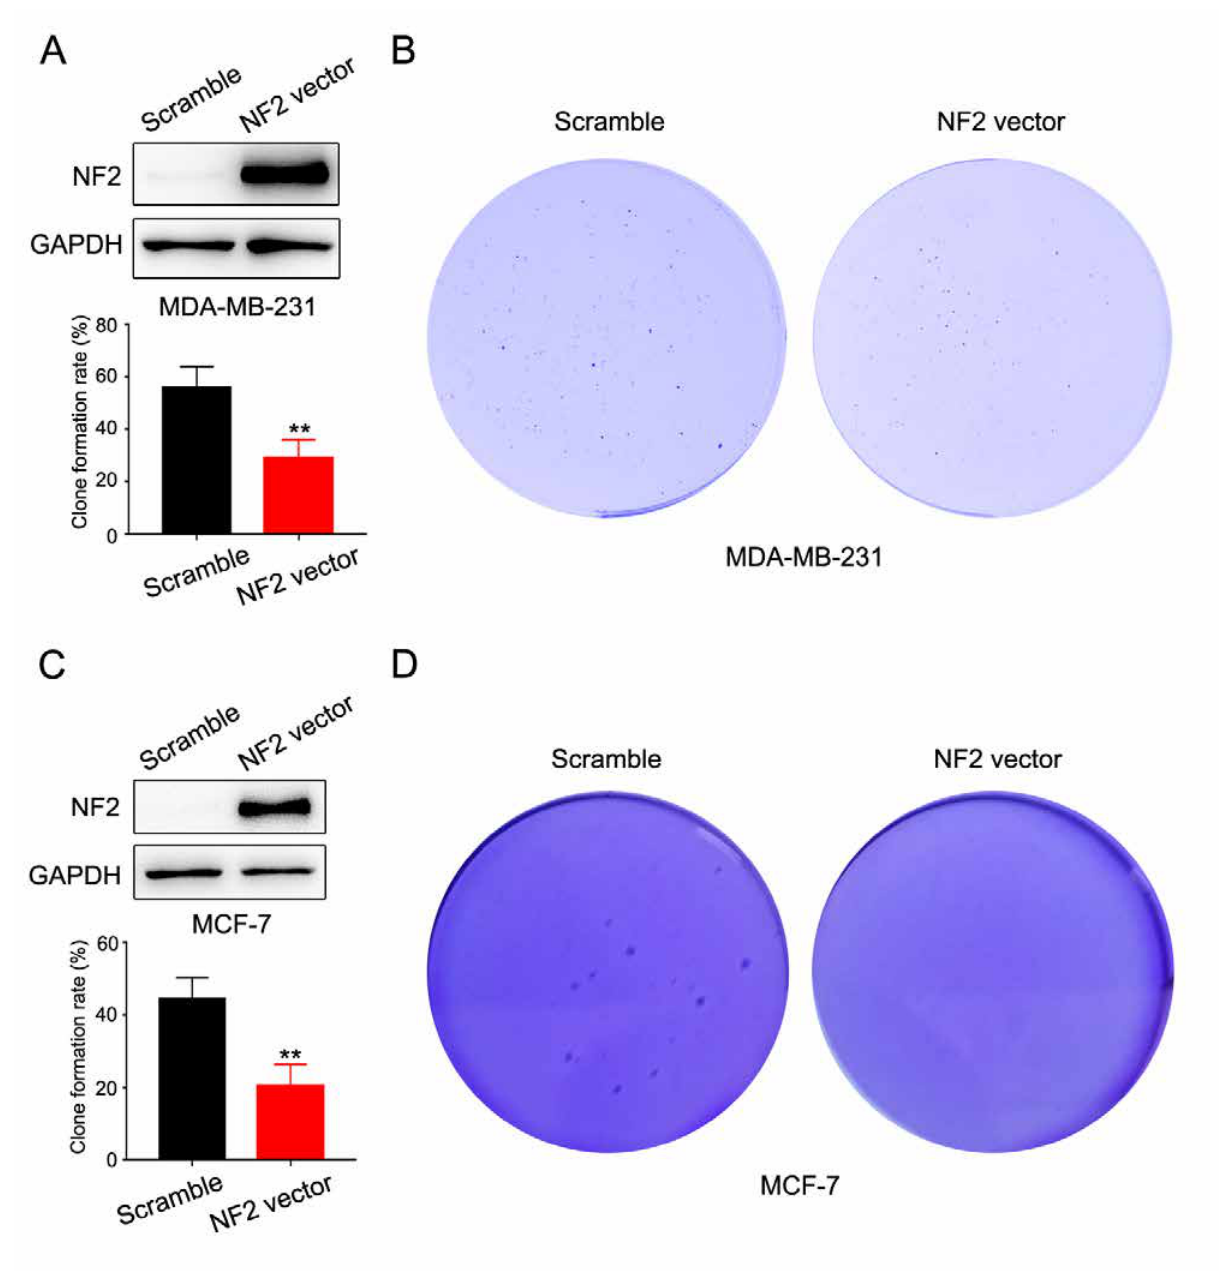
Figure 3: A Western blot analysis of the overexpression of NF2 in MDA-MB-231 cells (up). Clone formation rate of scramble and NF2 vector transfected MDA-MB-231 cells (down). B Representative images of MDA-MB-231 cell colonies in the colony formation assay. C Western blot analysis of the overexpression of NF2 in MCF-7 cells (up). Clone formation rate of scramble and NF2 vector transfected MCF-7 cells (down). D Representative images of MCF-7 cell colonies in the colony formation